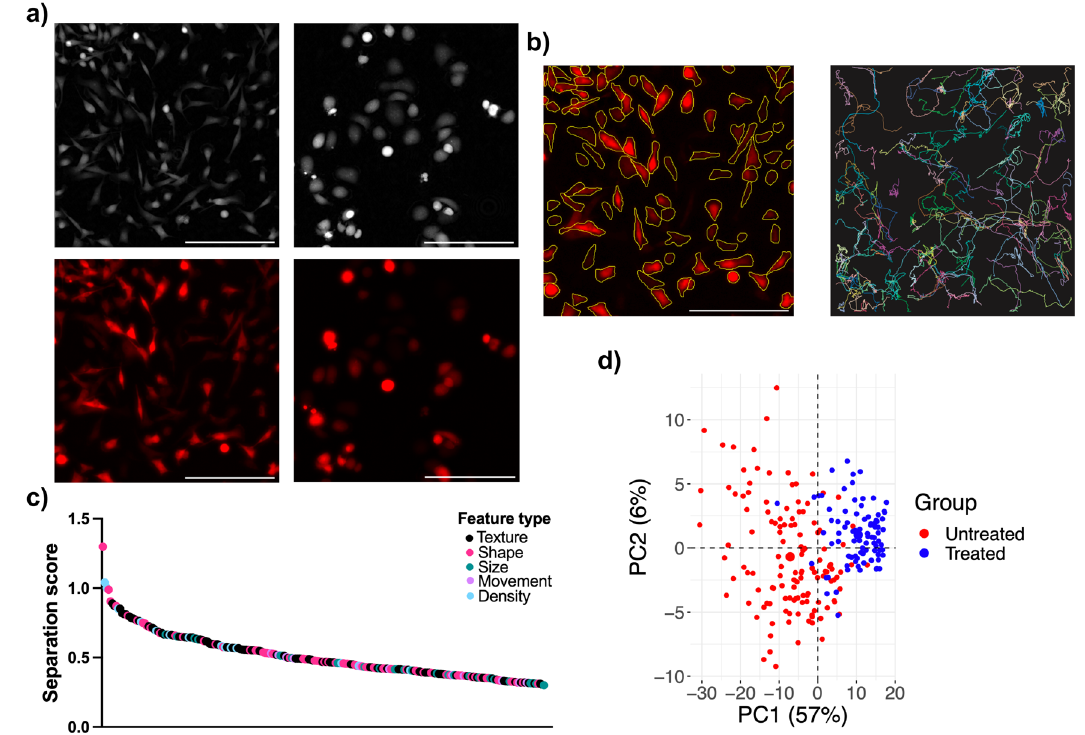
Fig. 7 | Application of CellPhe to fl uorescence images. a Images taken from cell time-lapses of untreated and 1 μ M docetaxel treated MDA-MB-231 cells stably expressing dsRed. Phase and fl uorescence images were acquired in parallel. Scale bar=200 μ m. b Representative image of Cellpose segmentation on a fl uorescent image of MDA-MB-231cellsstablyexpressing dsRed with celltracks obtained from TrackMate for untreated MDA-MB-231 cells stably expressing dsRed. Only cell tracks greater than or equal to 50 frames are displayed. c Features with separation